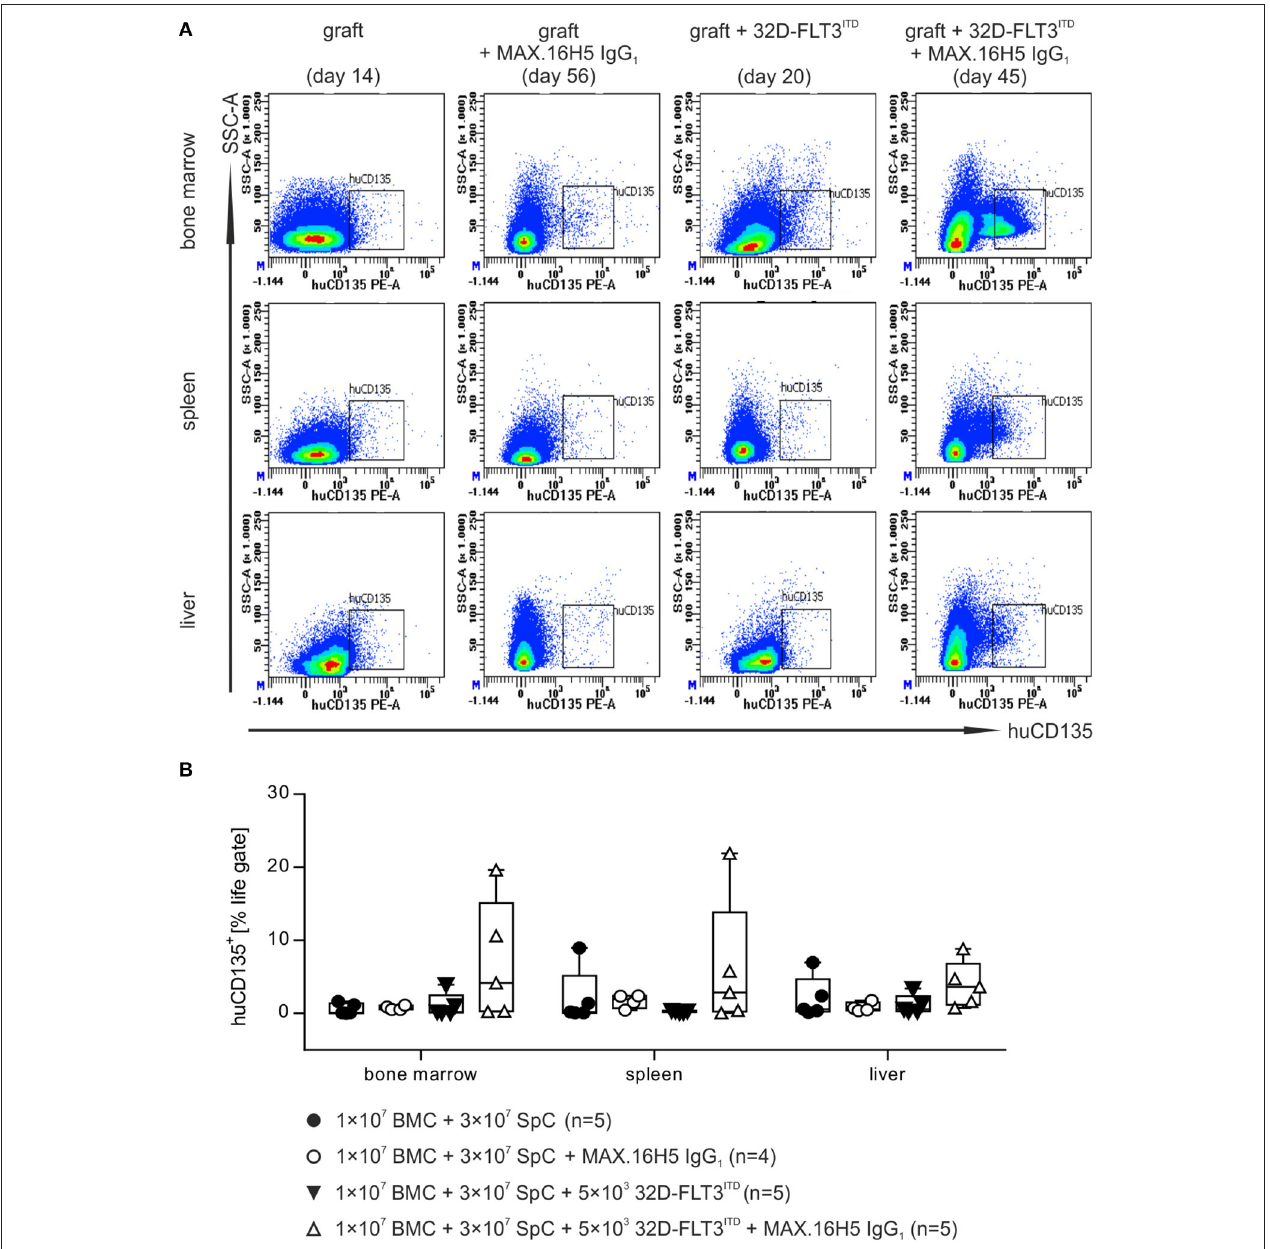
FIGURE 4 | Flow cytometric analysis of human CD135 + events in different organs after transplantation of bone marrow and spleen cell grafts pre-incubated either with or without MAX.16H5 IgG 1 in combination with or without co-transplantation of 32D-FLT3 ITD cells. The manifestation of human CD135 + cells in different organs (bone marrow, spleen and liver) from animals receiving 1 × 10 7 bone marrow cells (BMC) and 3 × 10 7 splenocytes (SpC) together with AML cells was analyzed by flow cytometry. (A) Representative plots from flow cytometric analyses of human CD135 + events after transplantation of untreated or MAX.16H5 IgG 1 -treated grafts with or without 5 × 10 3 32D-FLT3 ITD cells. At the endpoint, bone marrow, spleen, and liver samples from the transplanted mice were examined regarding human CD135 expression. (B) Human CD135 + events as percentage of the viable cell parent gate in organ preparations of recipient mice. Every symbol indicates one animal at a defined time point. The presented data is a collection of endpoint measurements combining samples from mice, which were analyzed as soon as they had to be taken out of the experiment or as soon as they died. Engraftment and proliferation of human CD135 + cells were detected in two out of five animals receiving MAX.16H5 IgG 1 pre-incubated grafts in the co-transplantation experiments with 5 × 10 3 32D-FLT3 ITD cells. Kruskal-Wallis test indicated no significant differences ( P = 0.171).